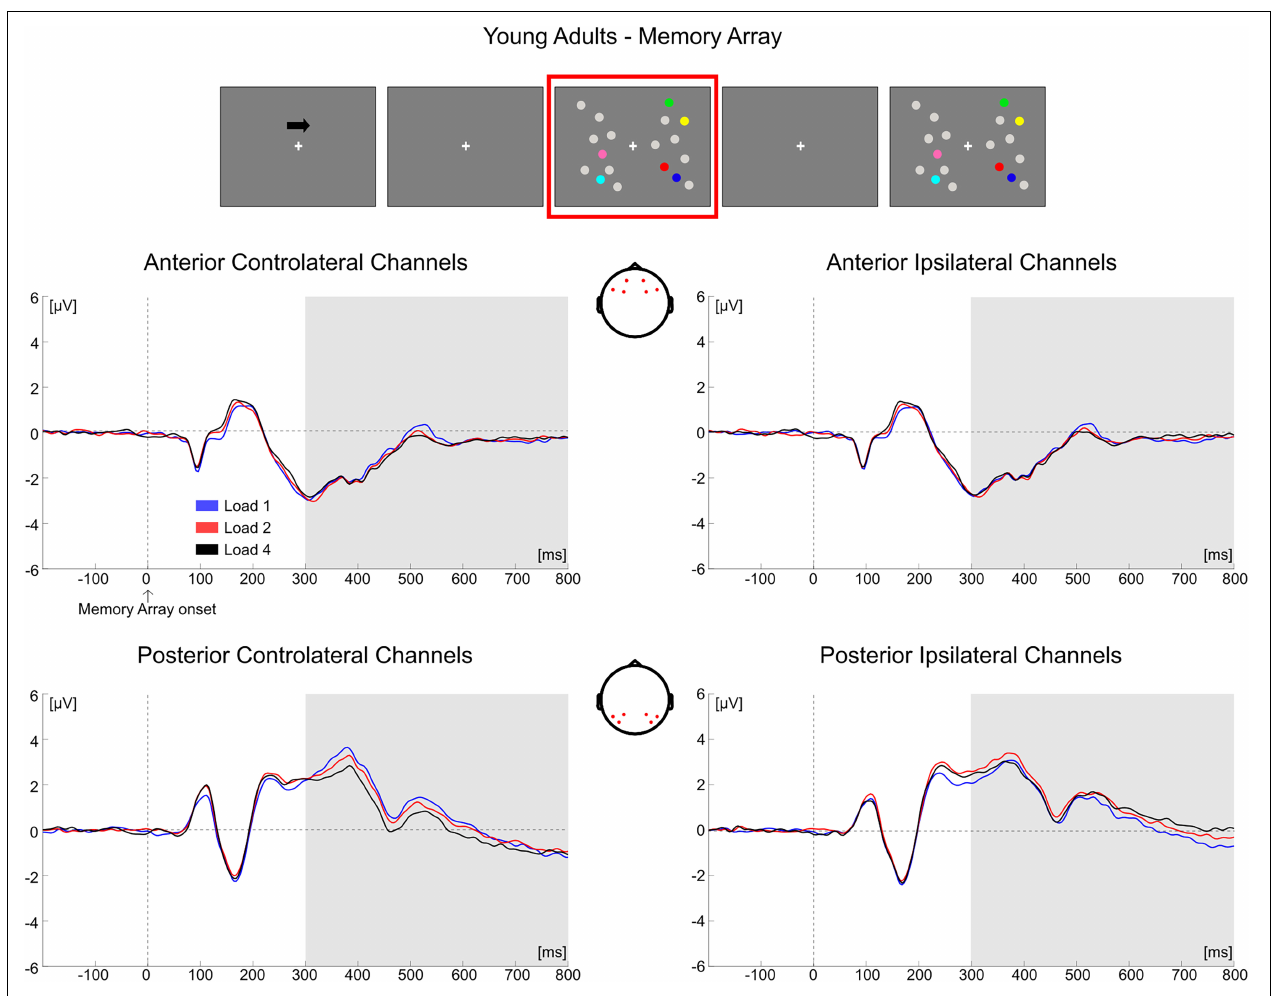
FIGURE 5 | Grand average waveforms as a function of target load over the anterior (Fp1/2, F3/4, F7/8) and posterior ROI (P7/8, PO7/8, P3/4), separately for contra- and ipsilateral to target channels, in the Younger group during memory retention. Topographies highlight the channels included in the ROIs and gray squares indicate the TOIs over which the mean amplitude was